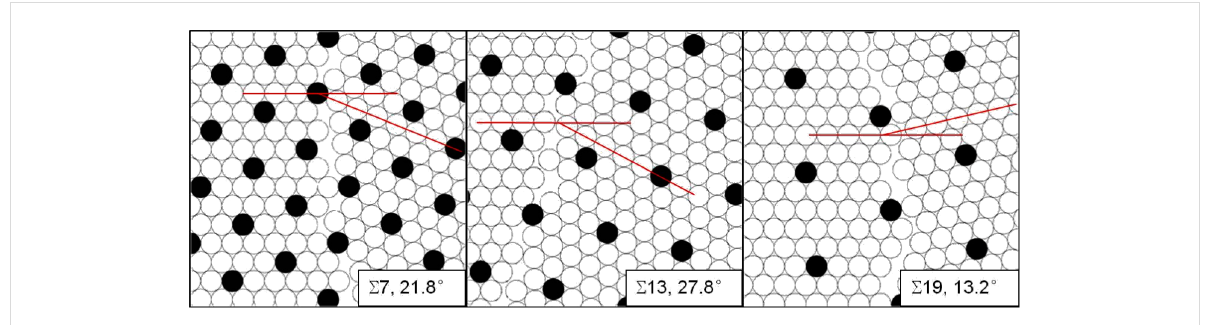
Figure 5: Coincidence site lattices for Σ = 7, Σ = 13 and Σ = 19.